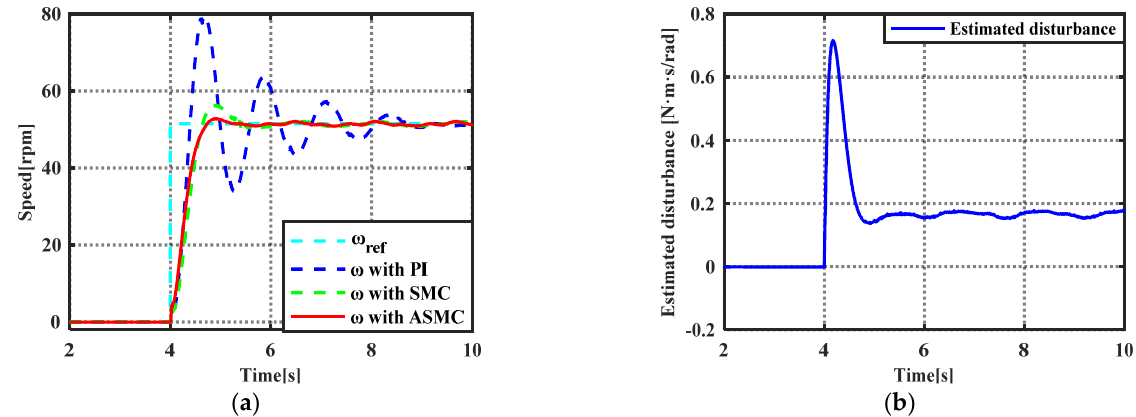
Figure 12. Experimental results of dynamic response and estimated disturbance during transient process. ( a ) Step response with three control strategies; ( b ) the estimated disturbances during transient process using proposed adaptive law.